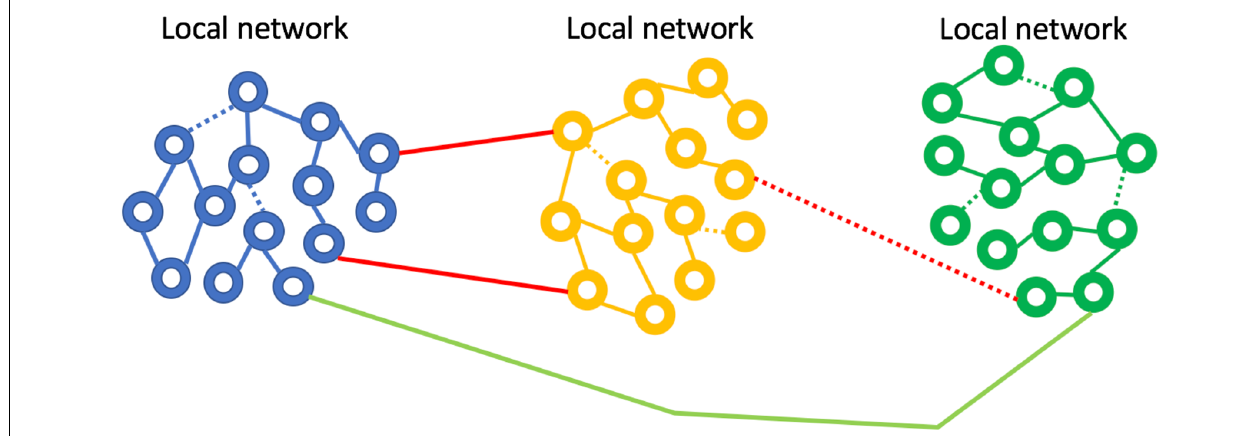
FIGURE 7 | Neurological disease represented as weak or broken network connections. Sensory neuromodulation is hypothesized to force activity in weak networks, strengthening synapses and improving coupling. The IGF-1 mechanism may be a key player in this network repair process.